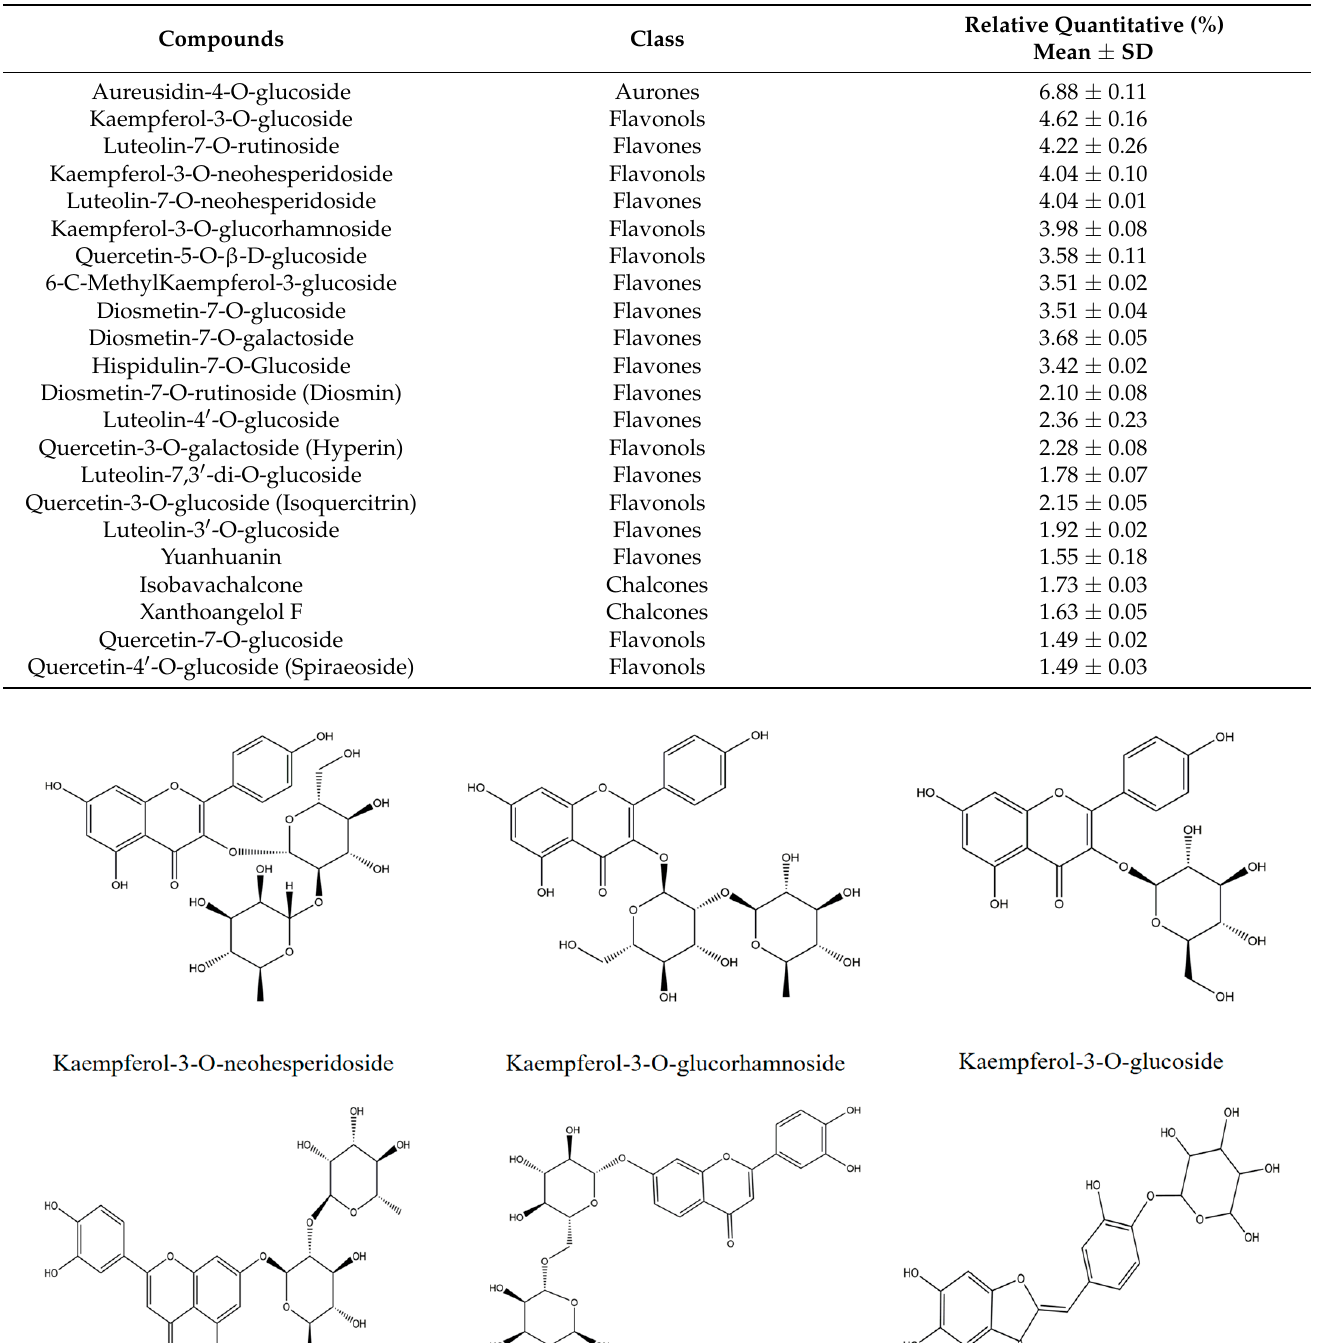
Table 1. Component analysis of flavonoids in the ethanol extract of A. keiskei . The relative quantifica- tion in Table 1 represents the response intensity of characteristic ions in the mass spectrum, which is the value calculated by the area of the mass spectrum peak.